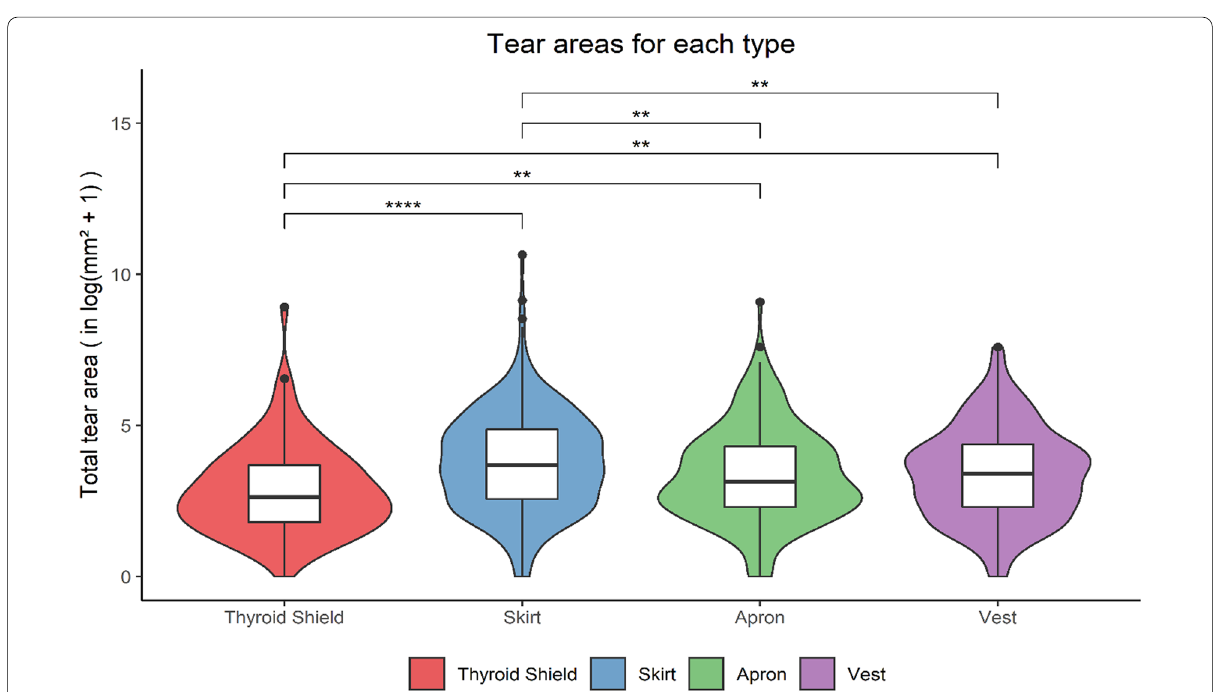
Fig. 3 Distribution of tear areas for each type of PRPE on the natural logarithmic scale. The stars indicate statistical significance resulting from Dunn’s post hoc test, and the number of stars indicates the level of statistical significance. Statistically, aprons and vests did not differ significantly in terms of total tear